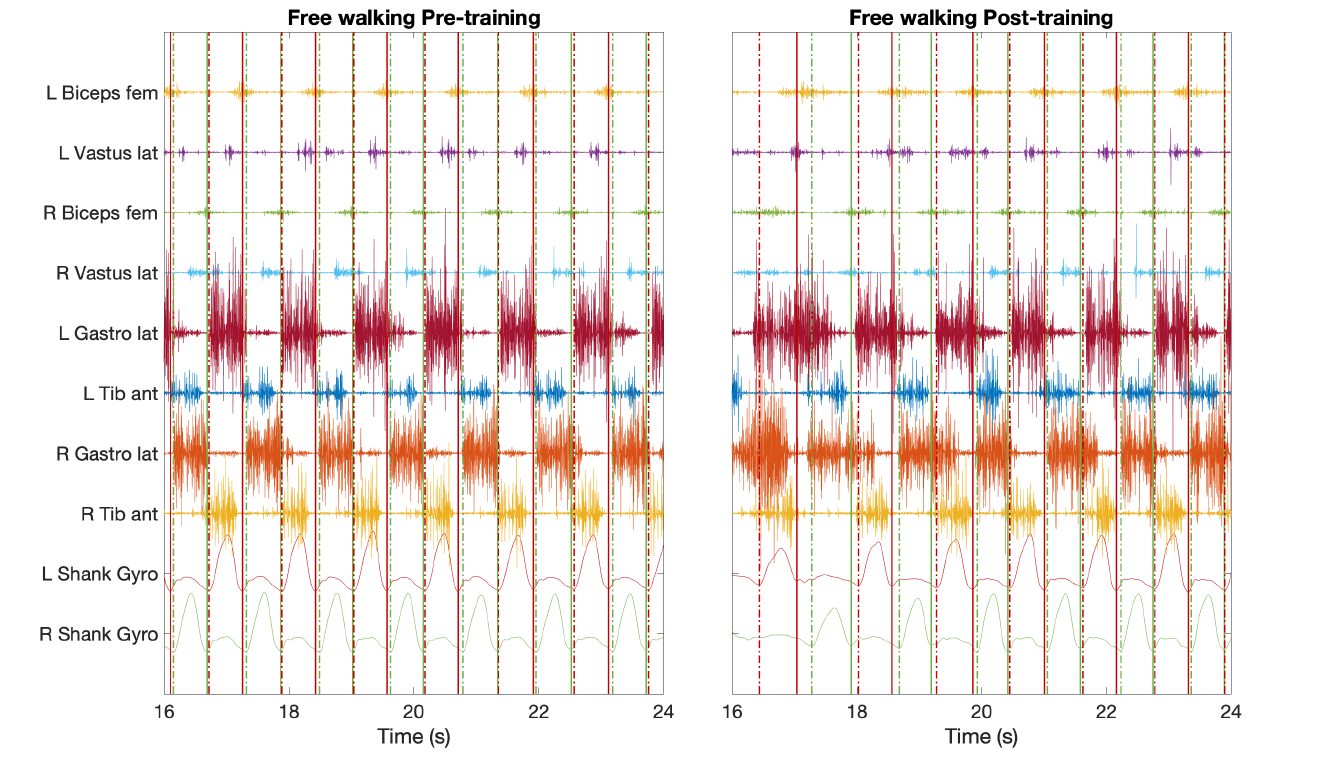
Figure 4. Example of filtered EMG time series during free-walking pre-training and free-walking post-training with the EKSO. Vertical lines correspond to foot-strike (solid lines) and foot-off (dashed) gait events. Red lines highlight the events for the left side, whereas the right side events are reported in